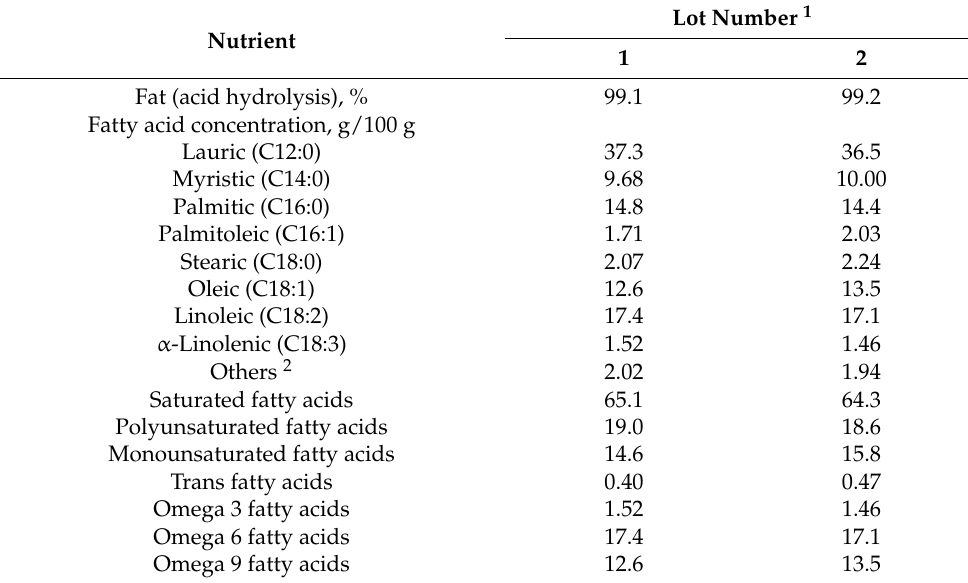
Table 2. Analyzed fatty acid composition of black soldier fly larvae oil. As fed